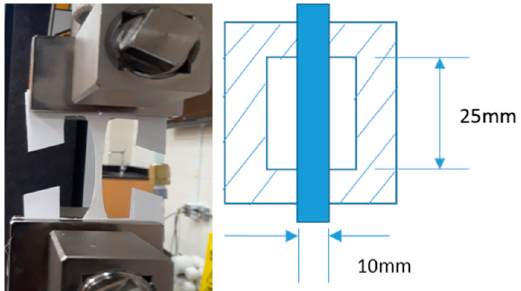
Figure 9. Test configuration and schematic of tensile test specimen.